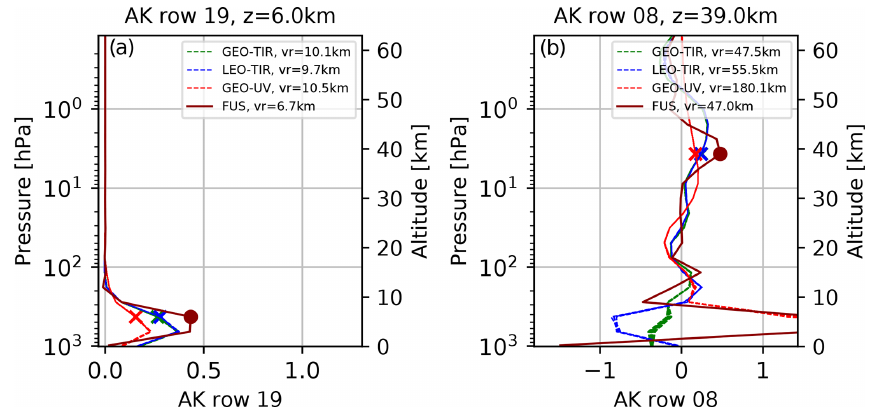
Figure 4. (a) Rows of AK matrices at 6km. (b) Rows of AK matrices at 39km GEO-TIR products (red lines), LEO-TIR products (blue lines), GEO-UV products (red lines) and the FUS product (dark red